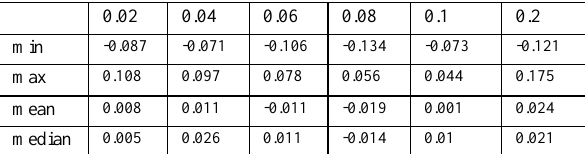
Table 3: Statistical analysis for the left edges in the six test cases of raster cell dimension analysis.